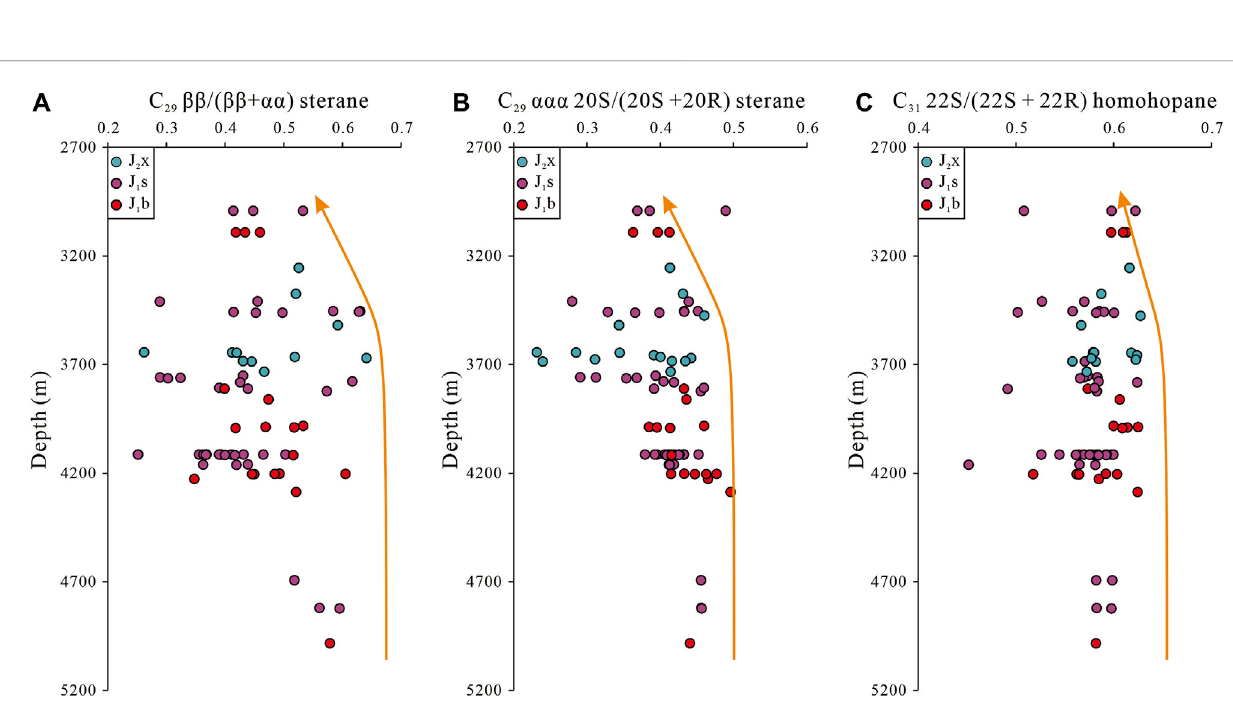
FIGURE 11 Plots of (A) C 31 homohopanes 22S/(22S + 22R) ratio, (B) C 29 ααα 20S/(20S + 20R) steranes and (C) C 29 ββ /( ββ + αα ) steranes vs depth of the Jurassic organic-rich shale in the East Fukang Sag, Junggar Basin,